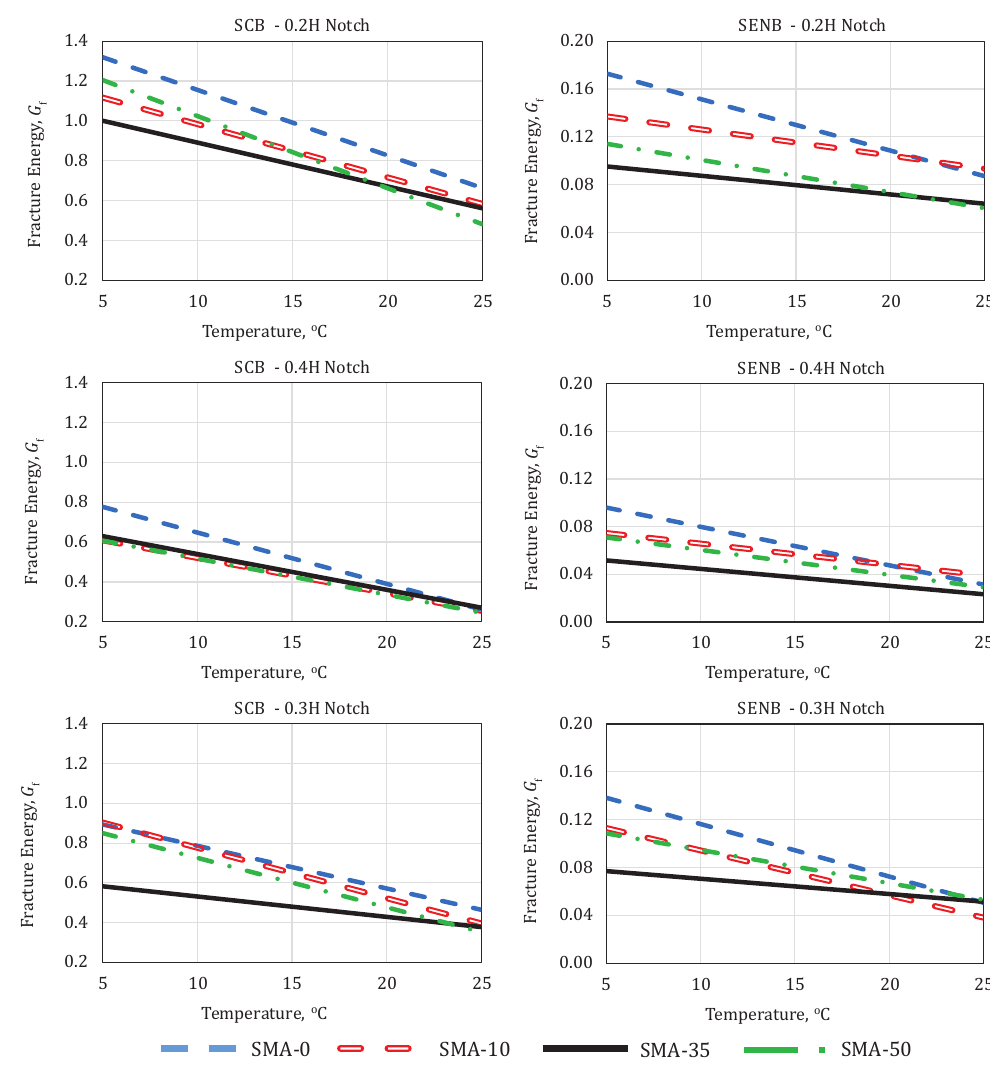
Figure 12. Fracture energy vs. temperature for varying notch depths SMA-0